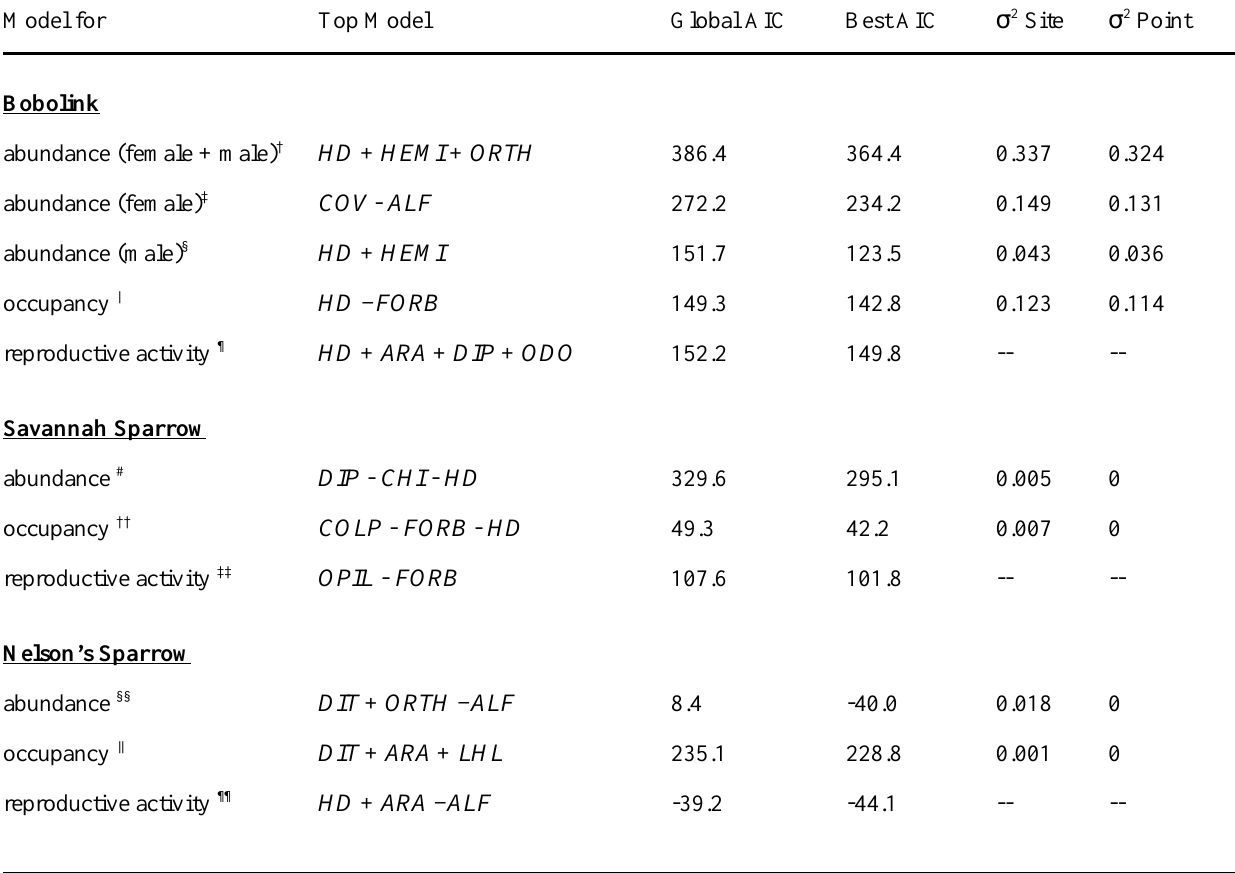
Table 2. Top models from the Nova Scotia study area for abundance, occupancy, and reproductive activity of Bobolink, Savannah Sparrow, and Nelson’s Sharp-tailed Sparrow. Model notation follows Table 1. For comparison, the value of Akaike’s Information Criterion (AIC) is provided for the global and final models. The variance associated with the random effects of site and point-count station is provided for models with mixed effects. Parameter estimates and standard errors are presented in Table 3. Footnotes indicate the retained variables used in model building for each model set. For occupancy and reproductive activity models, variables were retained if they had a Mallow’s Cp score (Mallow 1973) above that of a null model. Variables were retained for abundance models if they were within the upper 50% of highest individual F- statistics and had at least 0.10 pr